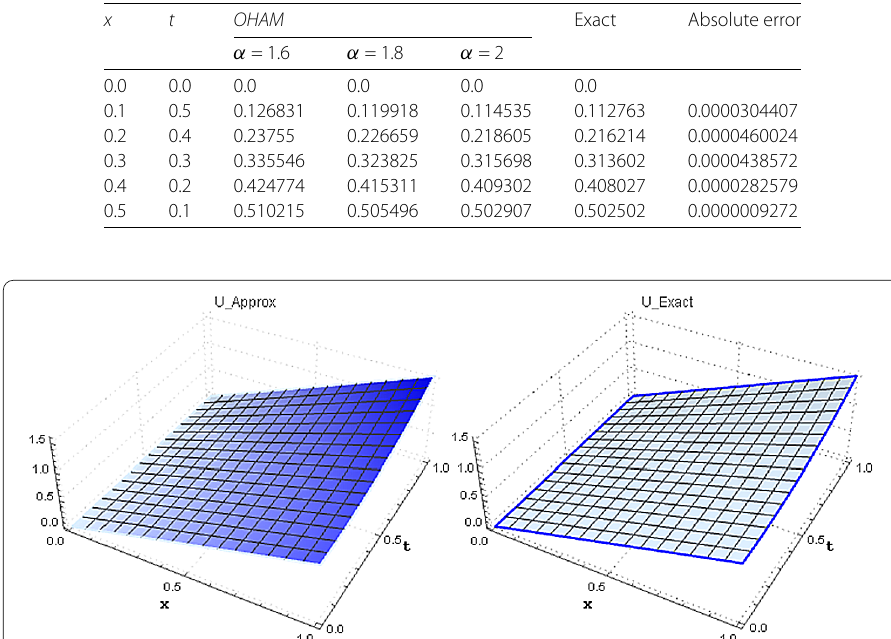
Table 4 Exact and approximate result of Test example 4.4 with various values of α